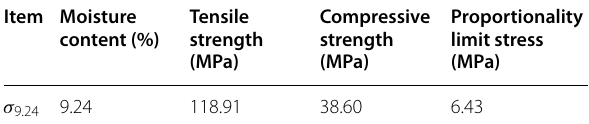
Table 3 Main mechanical characteristics of